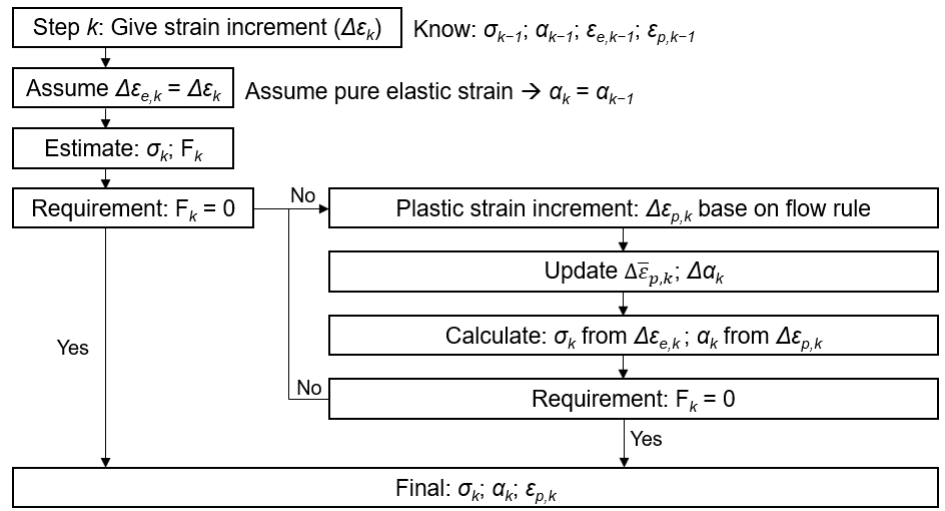
Figure 5. Algorithm for estimating back stress and plastic strain in MATLAB.